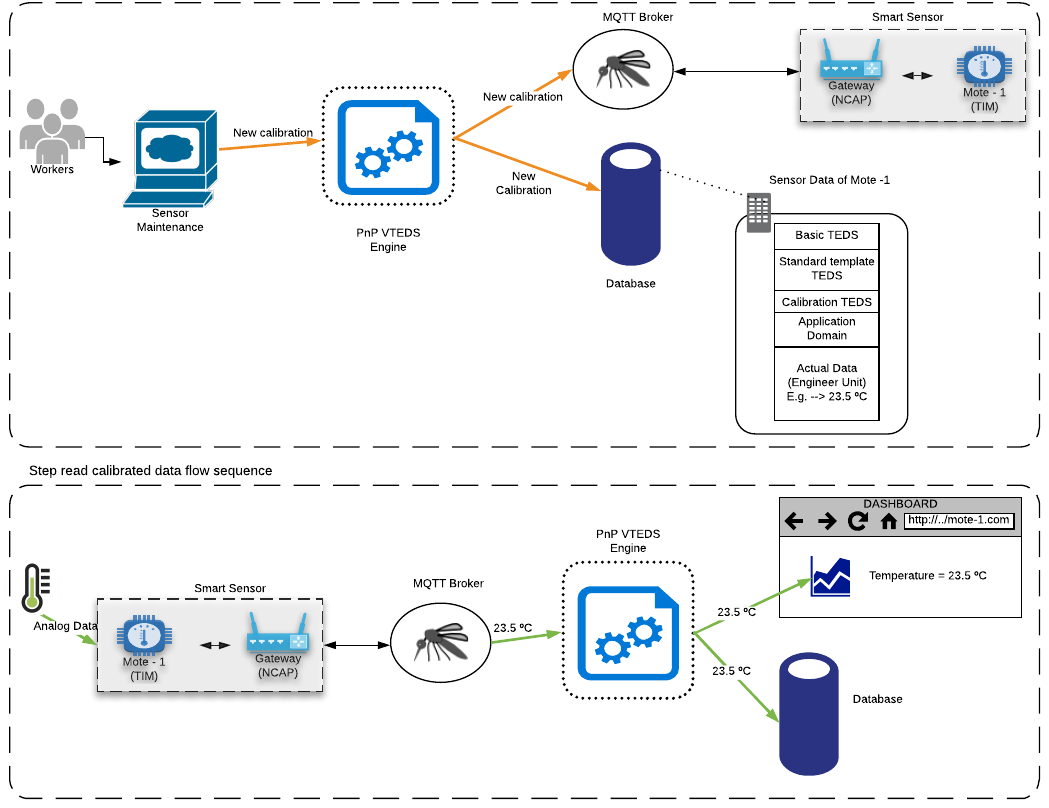
Figure 11. Data flows for new calibrations of